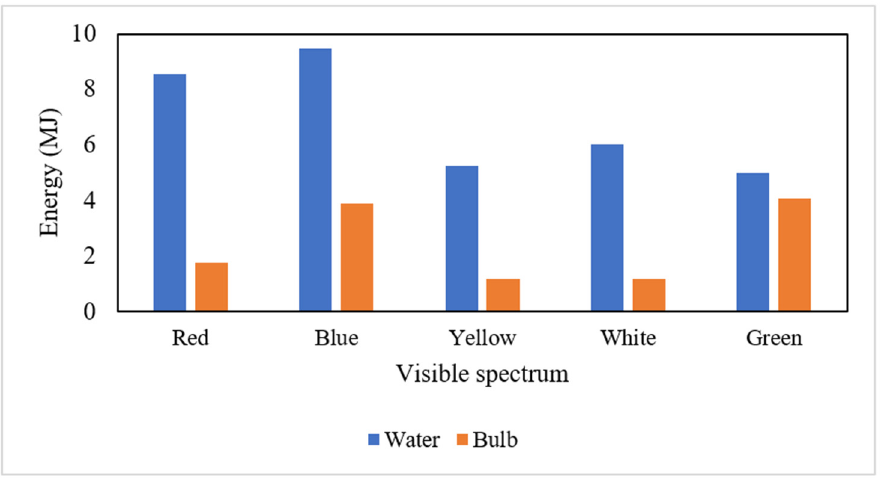
Figure 6. Energy inputs of water and light for growing attached microalgae on palm decanter cake at various visible spectra of irradiation.